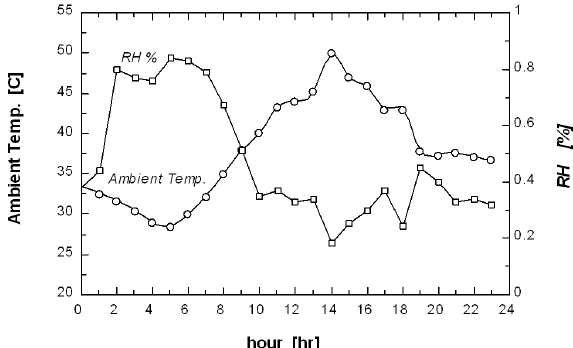
Fig. 4. Ambient temperature and RH variations on